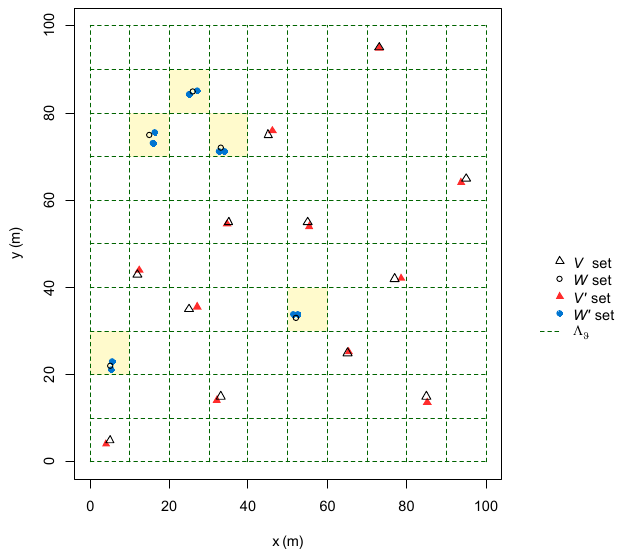
Figure 1. Schematic representation of exact, but unknown, single-sampled and resampled trees locations (sets V and W ) with the associated estimates (sets V’ and W’ ), whose coordinates are collected with a GPS device. As a consequence of its spatial resolution, the grid-based system Λ ϑ cannot resolve trees locations estimates included within the borders of the same pixel (highlighted in yellow if the case occurs). For this reason, the algorithm Φ Λ can assess which trees coordinates are likely to have been collected more than once. As shown in this example, all the elements of W’ , which are by definition replicated estimates of W elements, were detected.